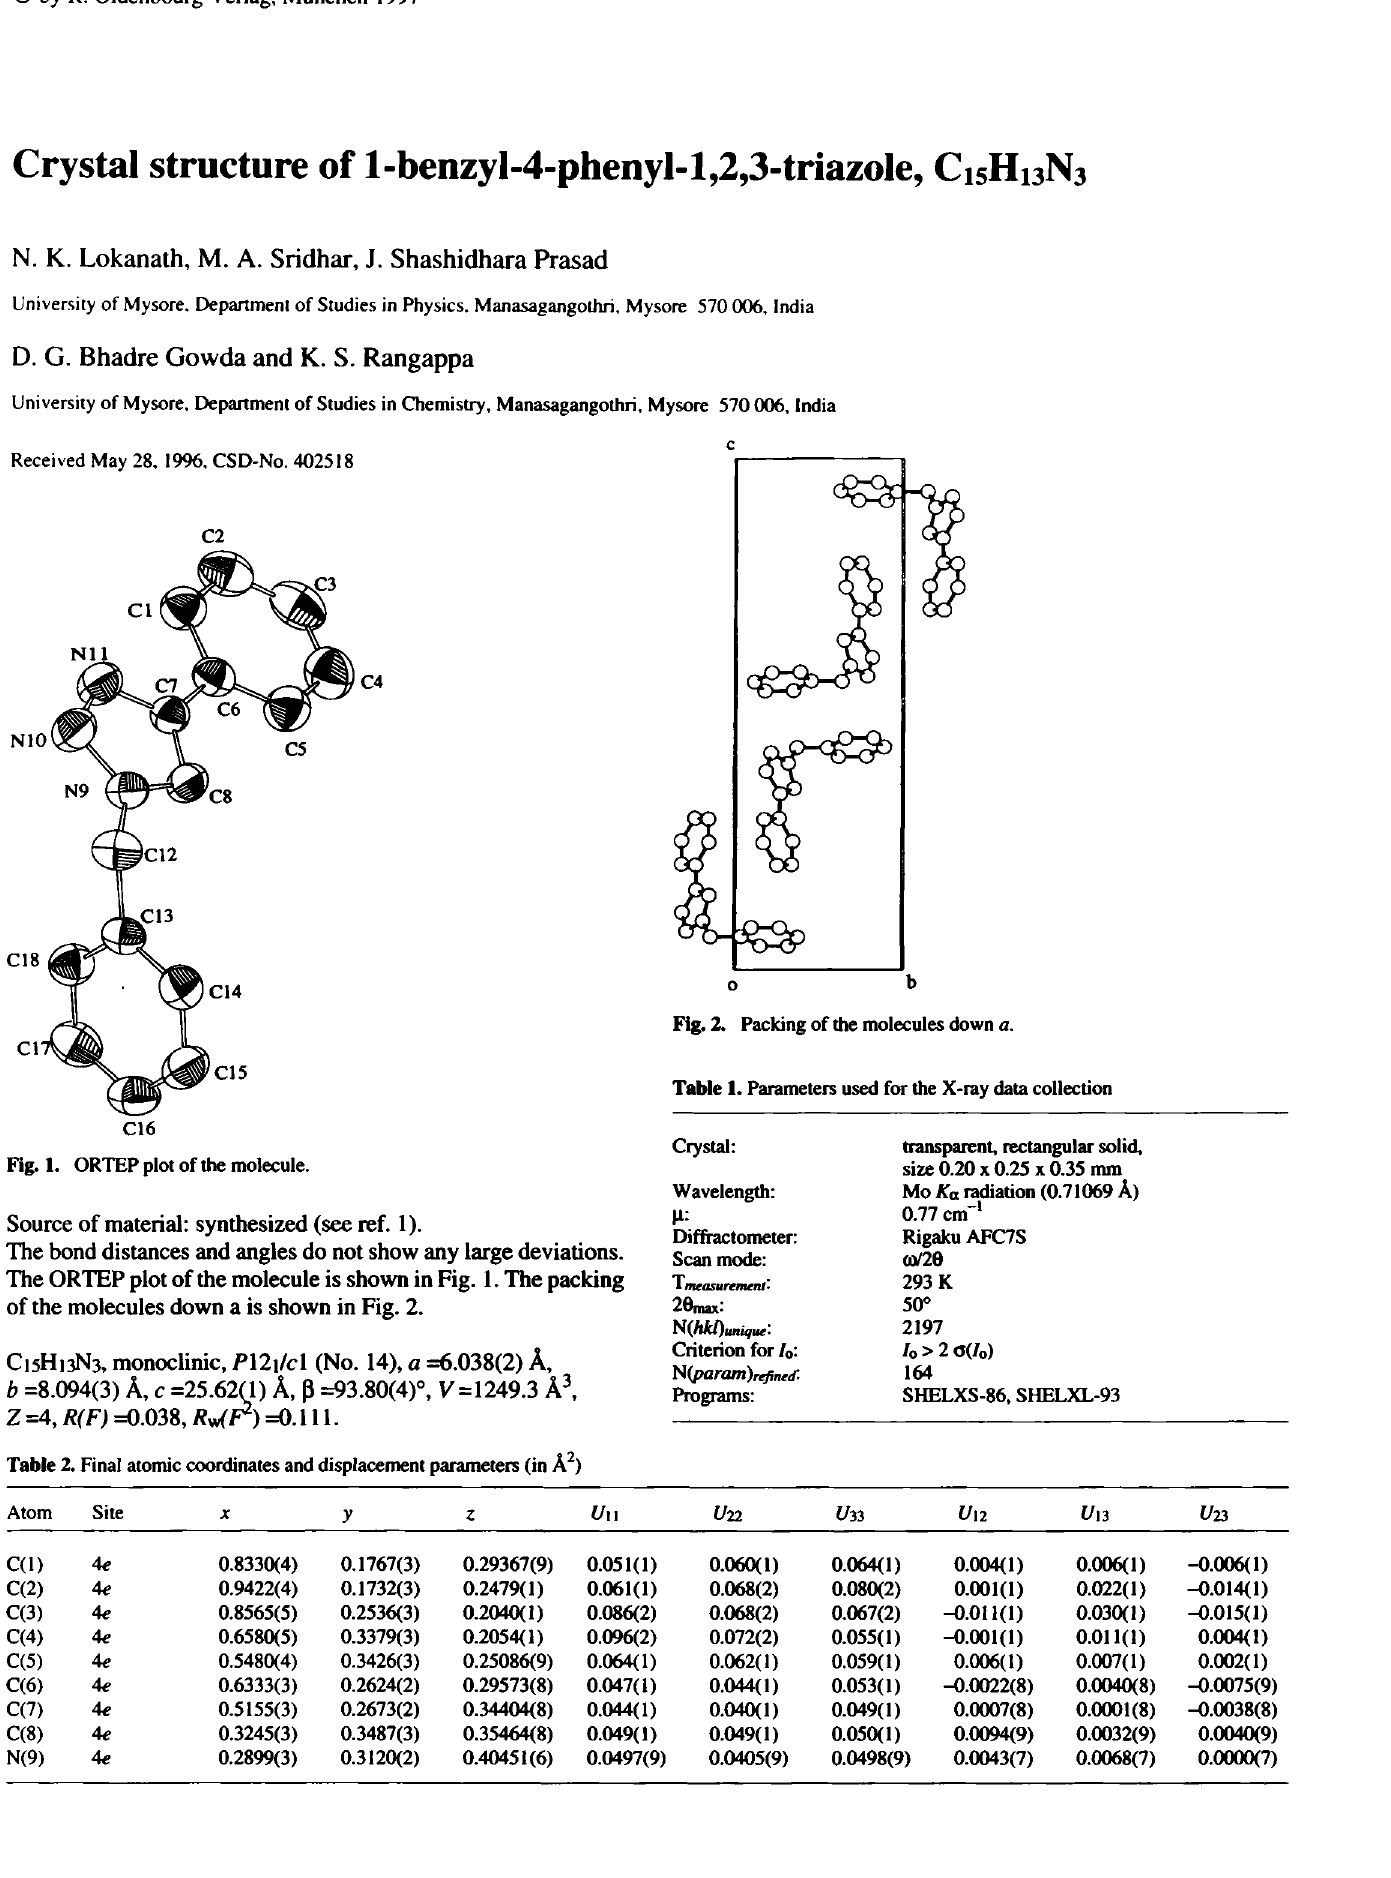
Fig. 1. ORTEP plot of the molecule. Source of material: synthesized (see ref. 1). The bond distances and angles do not show any large deviations. The ORTEP plot of the molecule is shown in Fig. 1. The packing of the molecules down a is shown in Fig. 2.